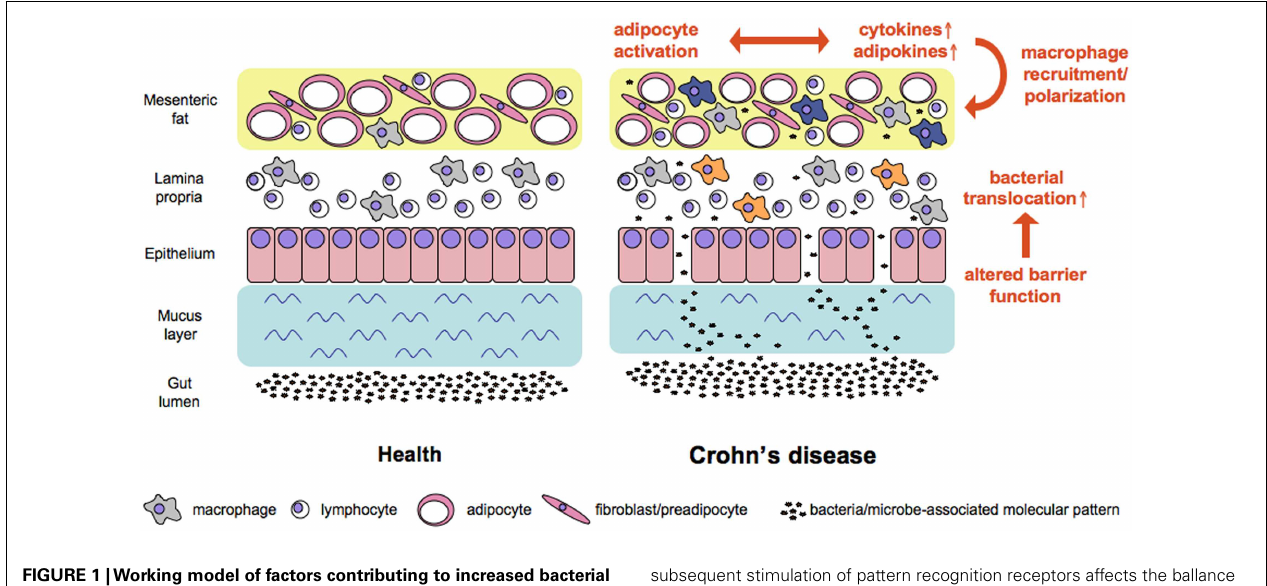
FIGURE 1 |Working model of factors contributing to increased bacterial translocation and adipose tissue activation in Crohn’s disease . Alterations in mucus and at the cellular level of the intestinal barrier all contribute to increased translocation of bacterial cells. Bacteria and microbe-associated molecular patterns reach adipose tissue where the